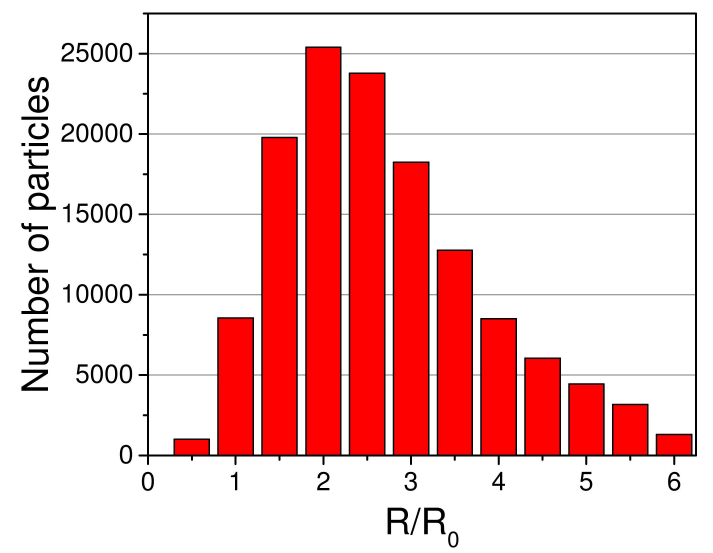
Figure 5. Lognormal distribution of 130,000 particles with median 1 and sigma 0.7. R 0 corresponds to radius of 5 µ